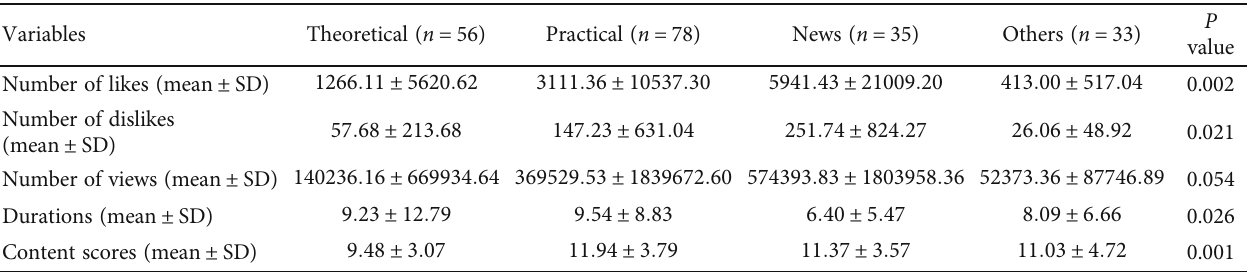
Table 8: Analysis of variables in relation to YouTube content theme on hydroponic